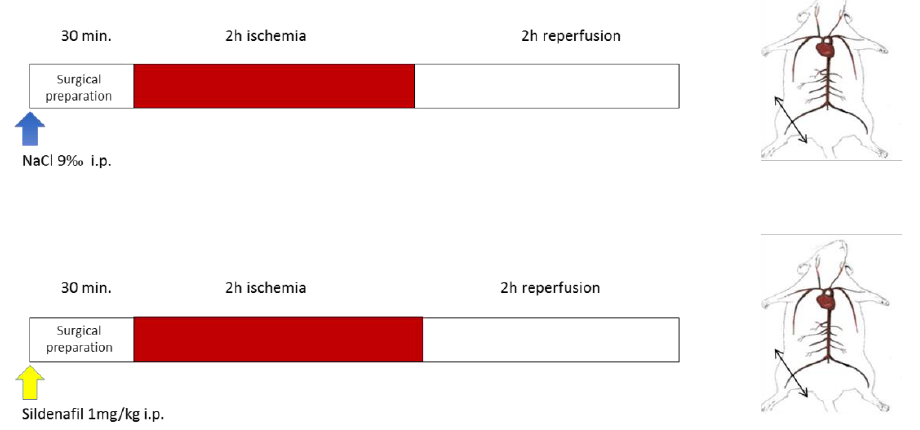
Figure 1. Experimental design. Top (NaCl): Ischemia-reperfusion (IR) animals underwent 2 h of unilateral hind limb tourniquet ischemia (red bar), followed by 2 h of reperfusion (open bar). The right, non-ischemic hind limb served as a control, and Nacl was administered ip 30 min before ischemia. Bottom (Sildenafil + IR): the same protocol was performed, but 1mg/kg sildenafil/NaCl ip was administered.